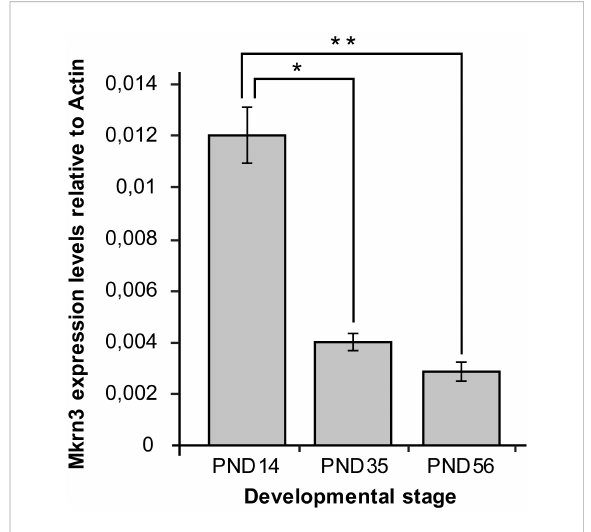
FIGURE 3 Hypothalamic Mkrn3 mRNA expression at pre-pubertal (PND14), pubertal (PND35) and post-pubertal (PND56) stages. *, P= 0.0000185, **, P= 0.0000082, one-way analysis of variance